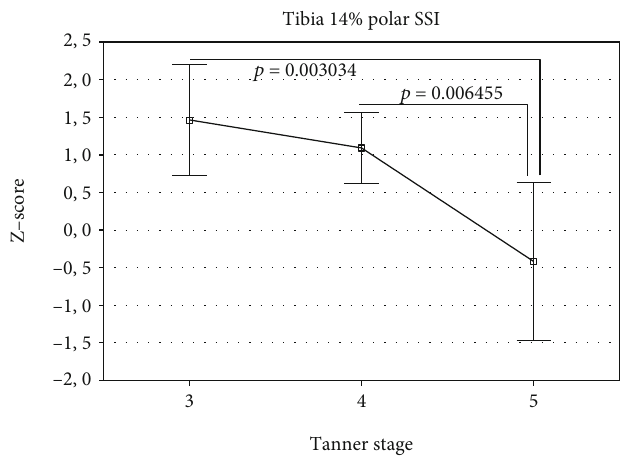
Figure 4: Z -scores for tibia 14% polar SSI in boys by Tanner stage (mean and 95%